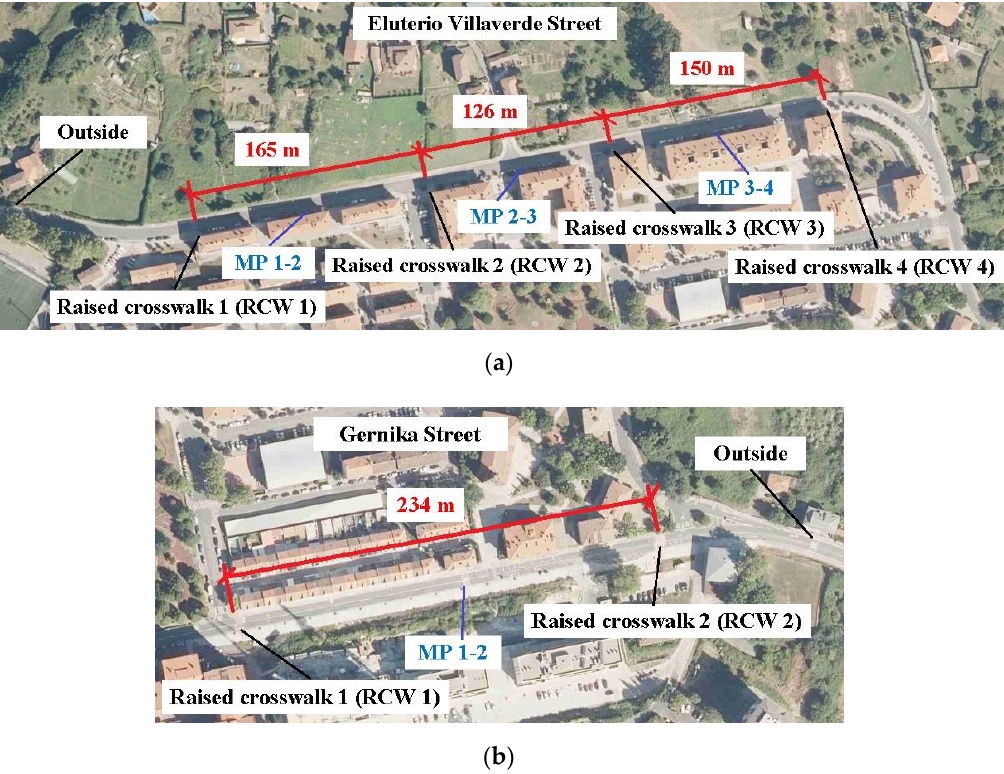
Figure 3. Schemes of traffic calming measures and measuring point in selected streets in Basauri (Spain): ( a ) Eluterio Villaverde Street; ( b ) Gernika Street.